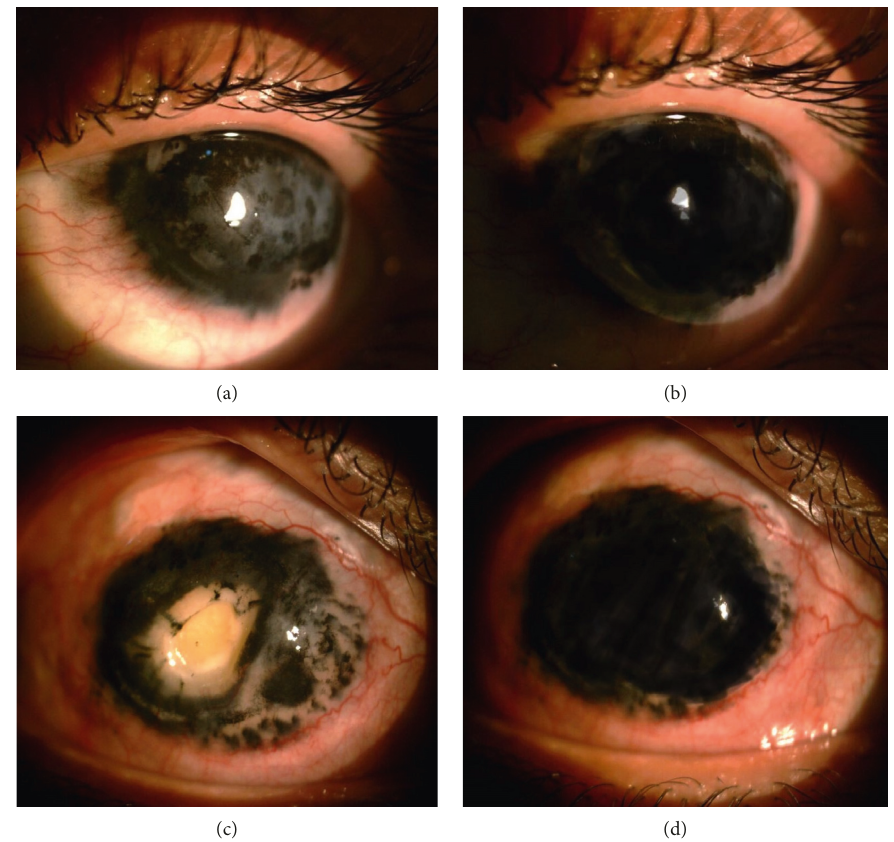
Figure 5: (a, c) Fading of the ink after 1 month; (b, d) retattooing after 3 months which made it homogeneous. Table 2: Percentage of patient